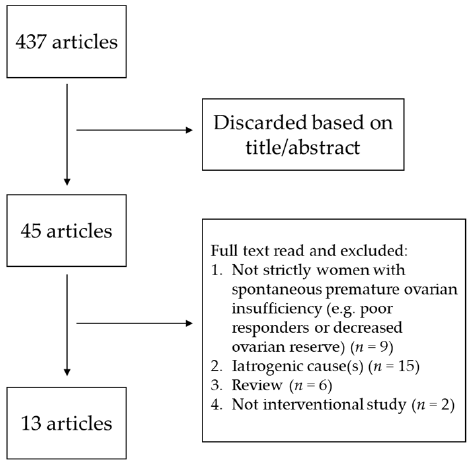
Figure 1. Flow diagram for the selection of the articles included in this review.